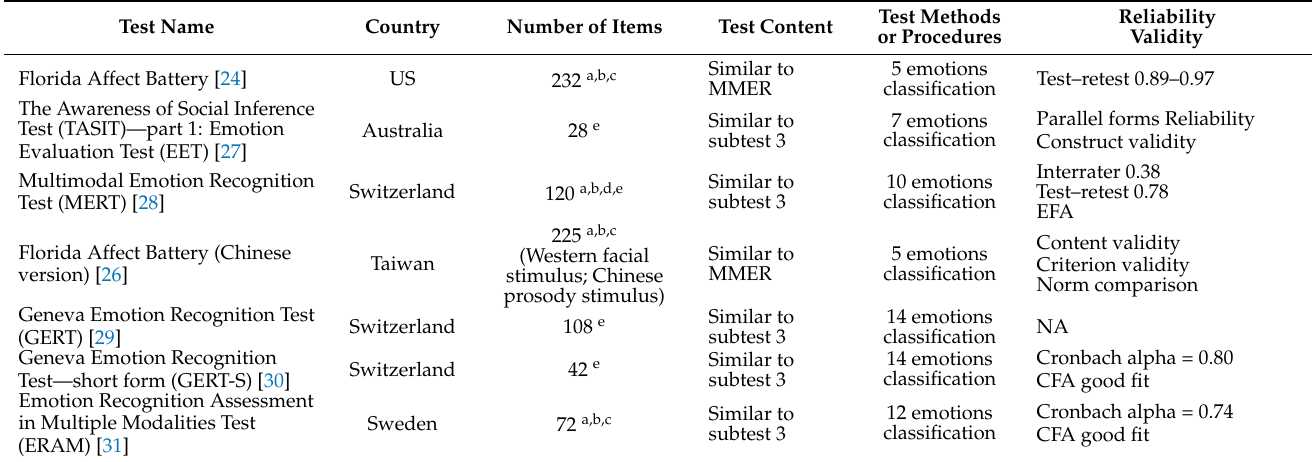
Table 2. Multi-modality emotion recognition tests with Western facial